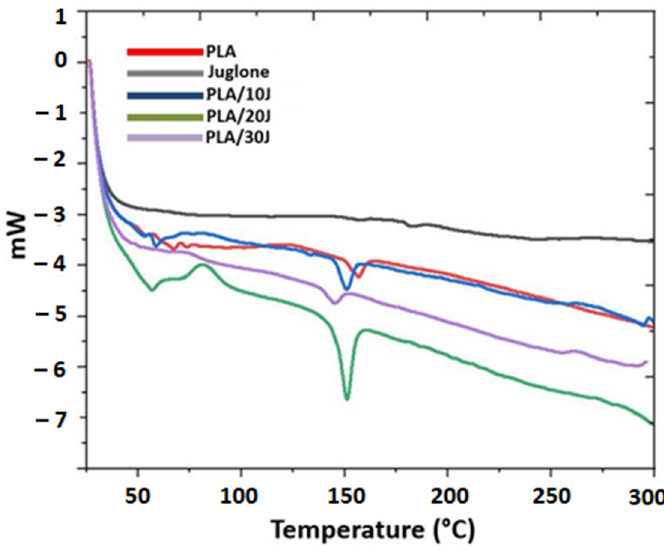
Figure 4. DSC curve of the pristine juglone and PLA/juglone electrospun scaffolds.